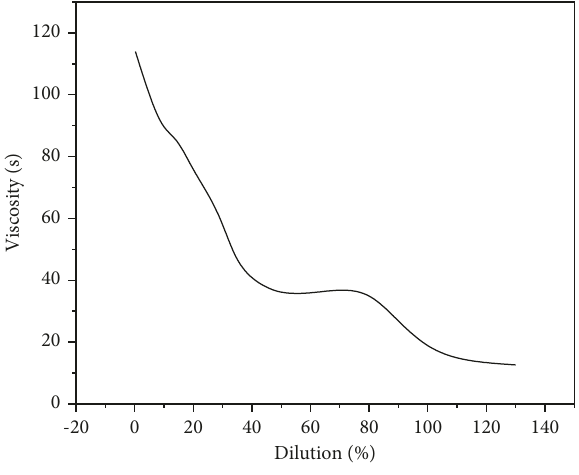
Figure 3: Viscosity-dilution